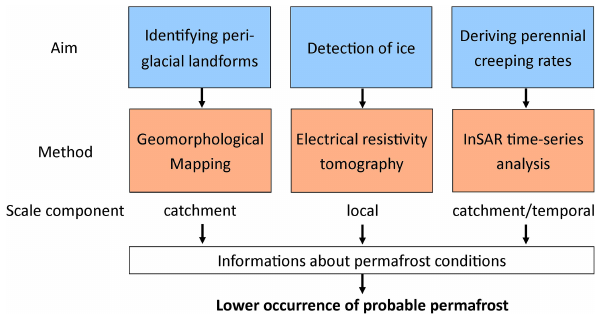
Figure 2. Schematic workflow of applied methods to assess lower occurrence of probable